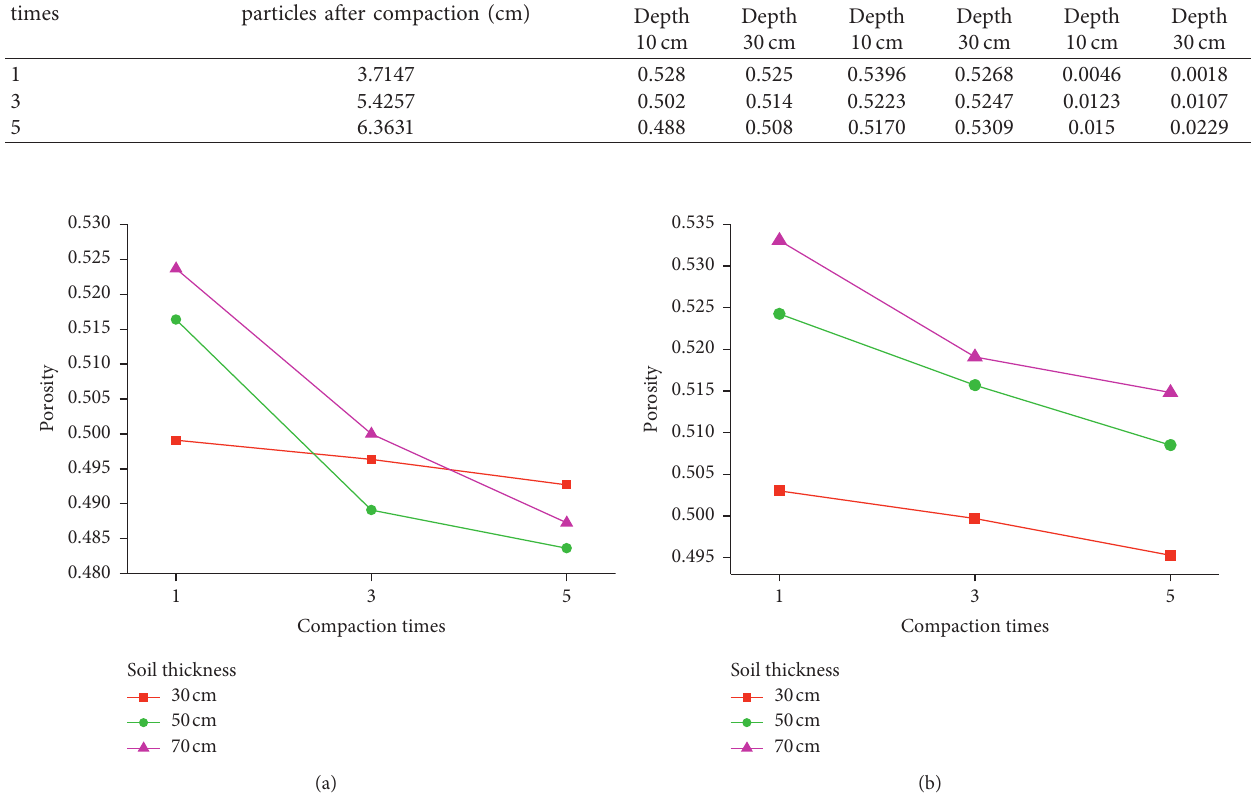
Figure 27: Curves of porosity of different thicknesses of soil with different compaction times: the results of (a) numerical simulation and (b) physical